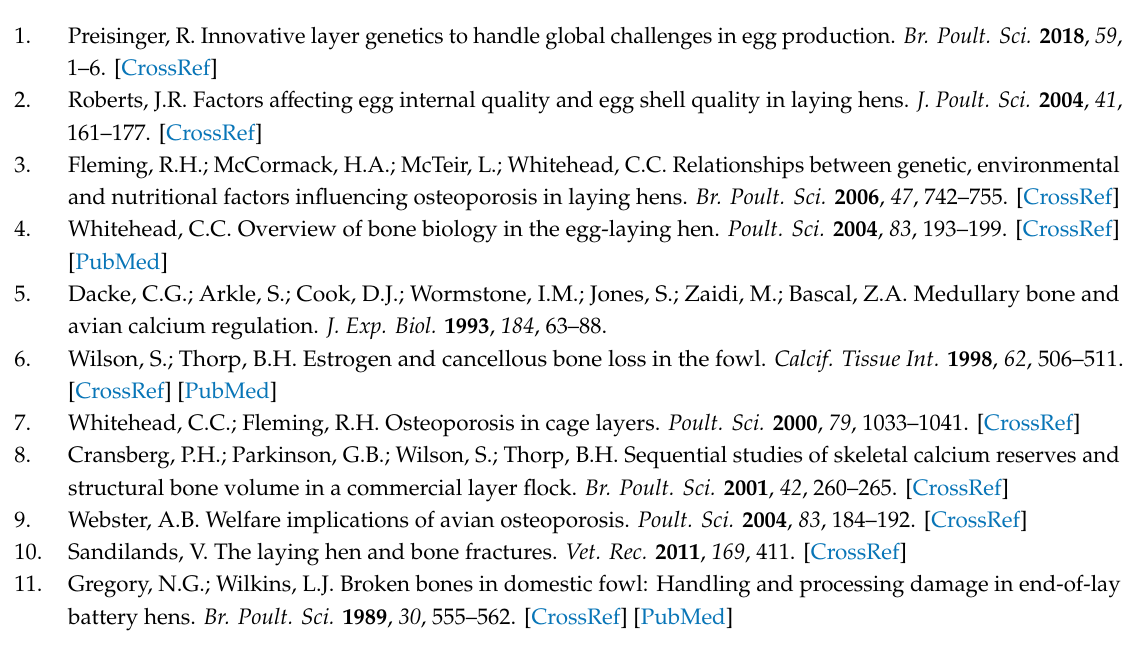
Table S1: Light program and mean climatic conditions, Table S2: Calculated nutrient compositions of the diets fed to the chicks during the first and second generations, respectively, and of the diet fed to the pullets during both generations, Table S3: Ingredients and analysed nutrient compositions of the experimental layer diets of the first and second generations, Table S4: The e ff ects of layer line, diet and their interaction on the observed bone traits and basic production parameters calculated within generations, Table S5: Sample sizes for the analysis, Table S6: Least squares means ± standard errors and level of significance for body weight measured at hatching and di ff erent weeks of age under the e ff ect of layer line (LL), generation (Gen) and their interaction. Author Contributions: Conceptualization, S.J., A.R.S. and S.W.; formal analysis, S.J., U.B. and A.R.S.;